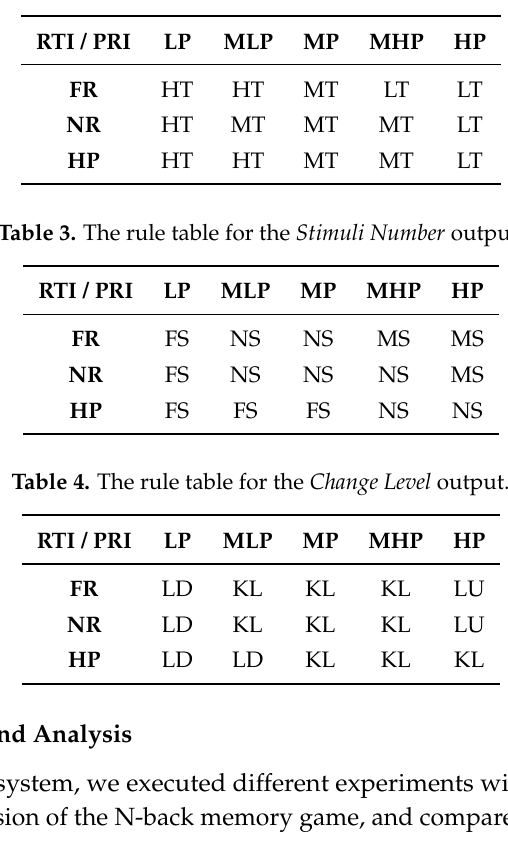
Table 2. The rule table for the Sample Time output.